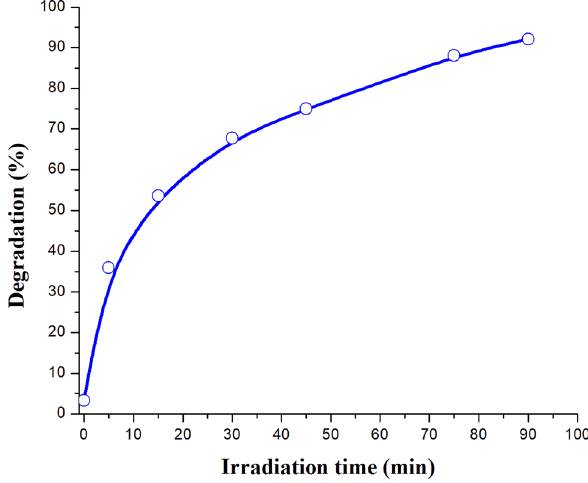
Figure 10: Degradation as a function of irradiation time of MO dye under solar irradiation on Fe – ZnO -